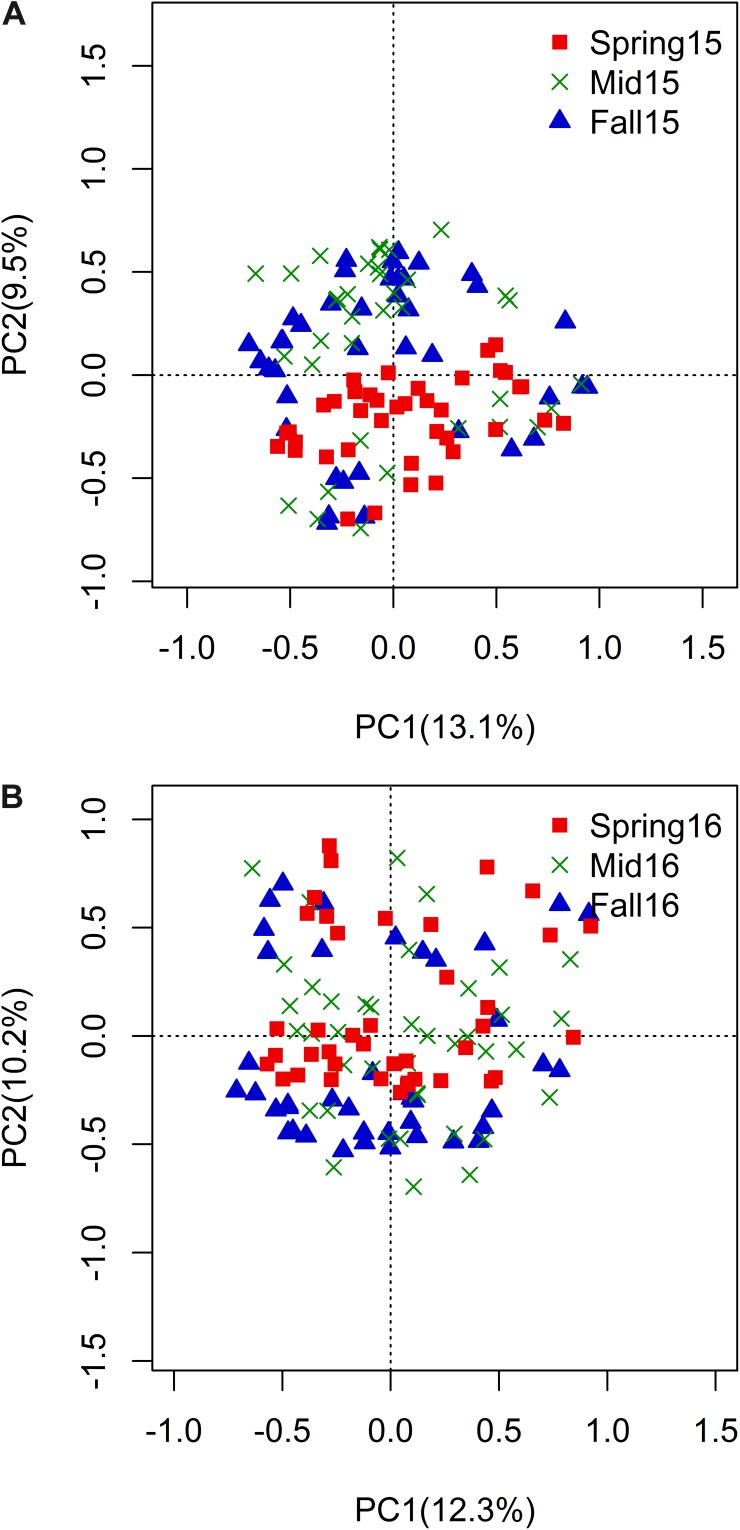
PCoA plot of Bray–Curtis distance matrix by season within year 2015 (A) and 2016 (B). Percentage of variation explained by season was shown on PC1 and PC2. Red squares = spring, green “x” = midseason, and blue triangles = fall.